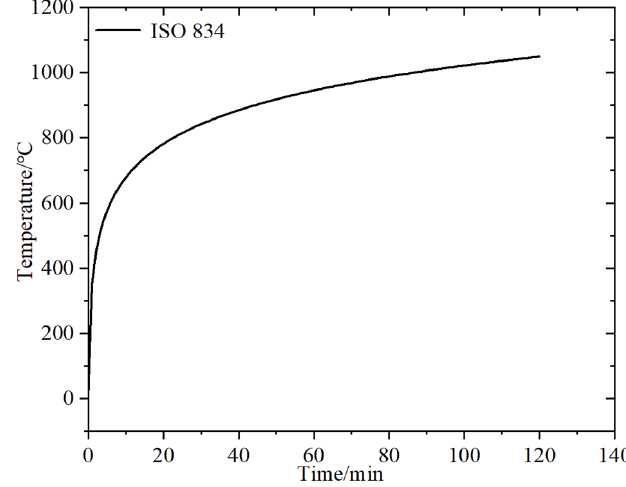
Figure 1. ISO 834 temperature–time curve.